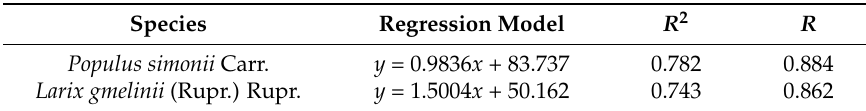
Figure 2. The relationship between the MC of the living trees as measured by ST-85 and by the oven drying method. Table 1. Relevant relationship between MC of standing trees as measured by ST-85 and by the method of oven drying.